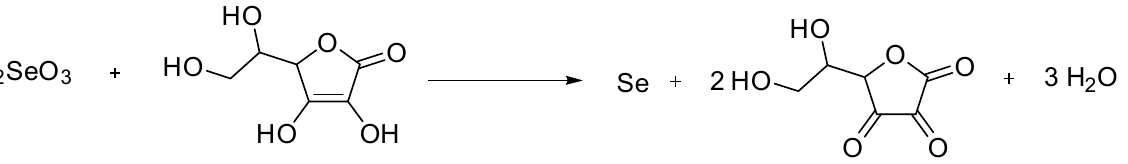
Figure 61. Selenium nanoparticles are formed by reducing them with ascorbic acid with the help of beta–lactoglobulin stabilizer. Investigations of development, physicochemical characterization and cytotoxicity of selenium nanoparticles stabilized by beta–lactoglobulin by Zhang et al.